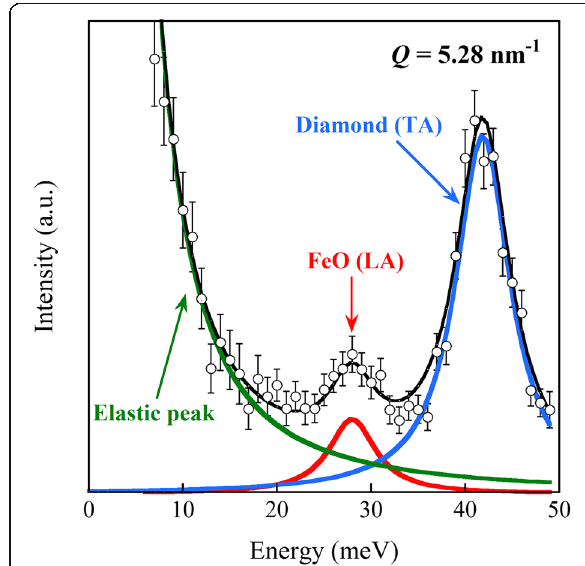
Fig. 1 An example of IXS spectra at 59.4 GPa and 1700 K. The spectra include individual contributions (elastic scattering, the longitudinal acoustic (LA) mode of tungsten, the LA mode of B1- FeO, and the transverse acoustic (TA) mode of the diamond